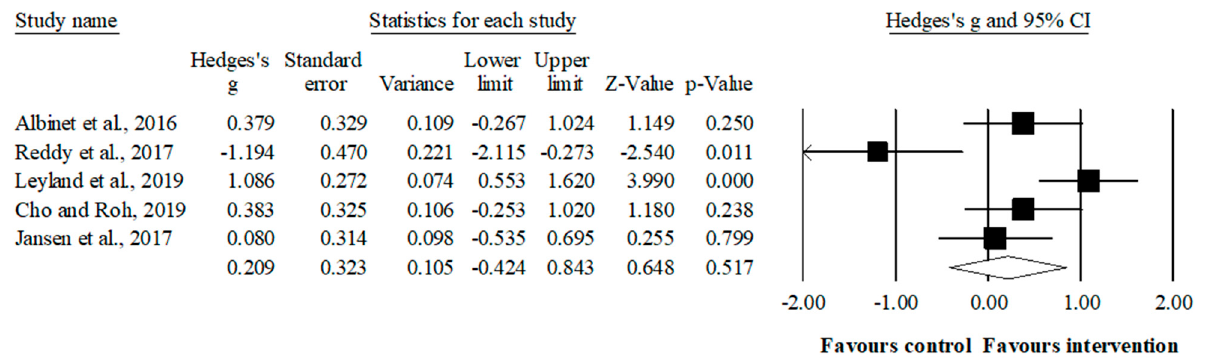
Figure 3. Forest plot of effects on inhibition. Values shown are effect sizes (Hedges’s g) with 95% confidence intervals. The size of the plotted squares reflects the statistical weight of the study [45,48,49,54,88] The meta-analysis for flexibility involved five studies, five experimental groups ( n = 146), and five control groups ( n = 134). Compared to the control group, the intervention had a small favoring but no significant effect (ES = 0.39, 95% CI = − 0.11–0.89; p = 0.131; I 2 = 75.5%). The results remained consistent during the sensitivity analysis (each study removed from the analysis once) (Figure 4).